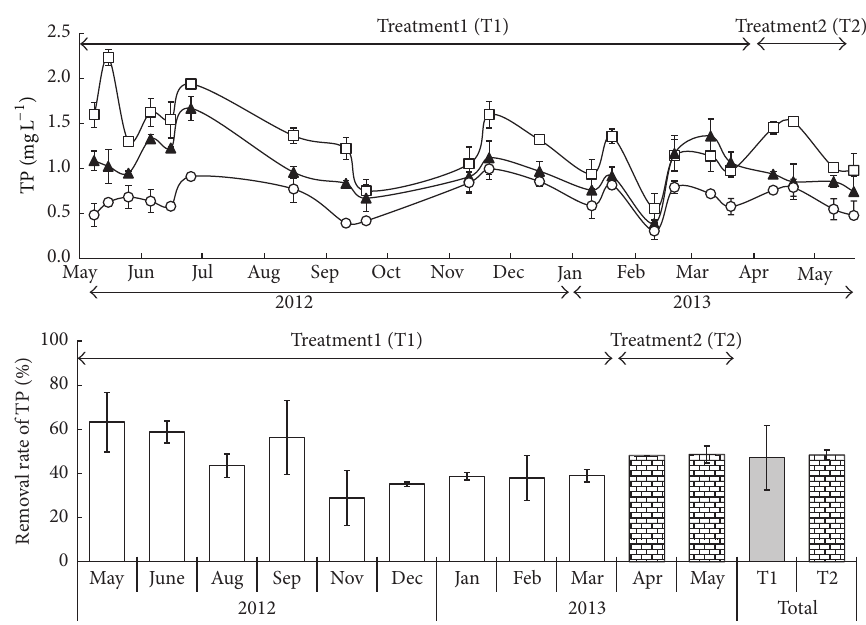
Figure 6: The concentration and removal rate of TP in the water with time in a VF-HF hybrid constructed wetland under different ventilation methods ( ◻ : inflow; 󳵳 : 1st treatment; I : 1st + 2nd treatment; Treatment1 (T1): VF-HF CWs with natural ventilation; Treatment2 (T2): VF-HF CWs with ventilation using an electric air fan